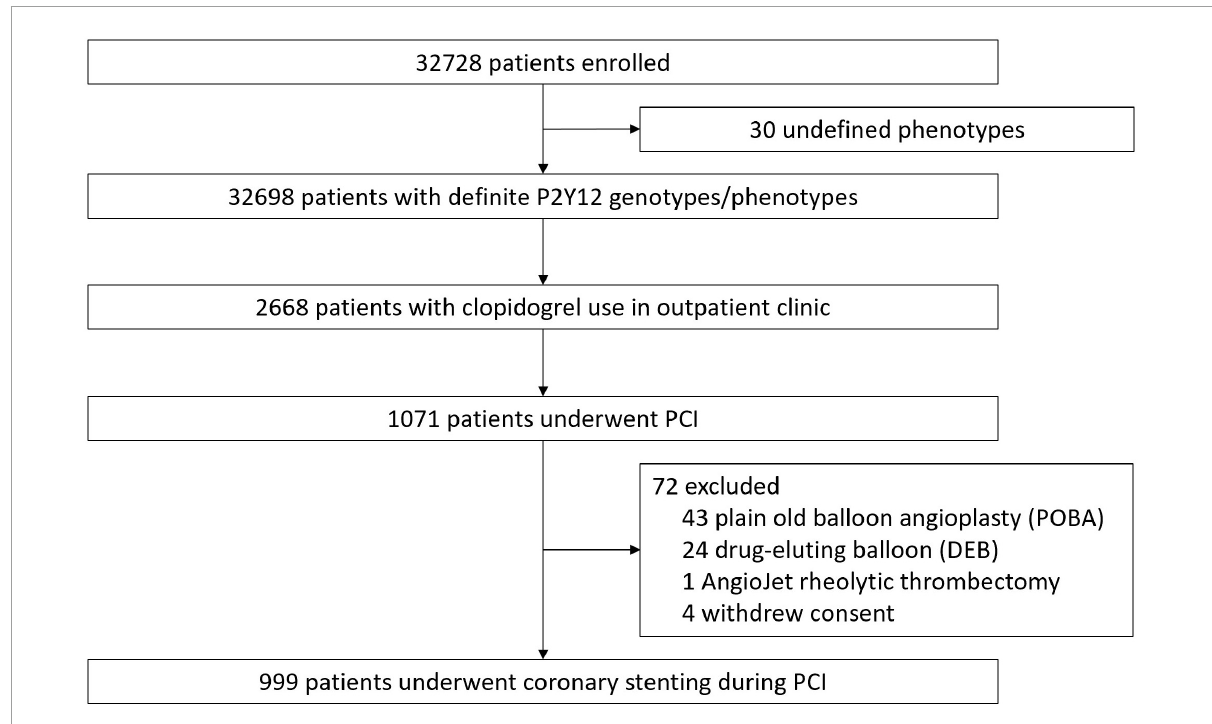
FIGURE1 Flowchart of the enrollment process in the study.